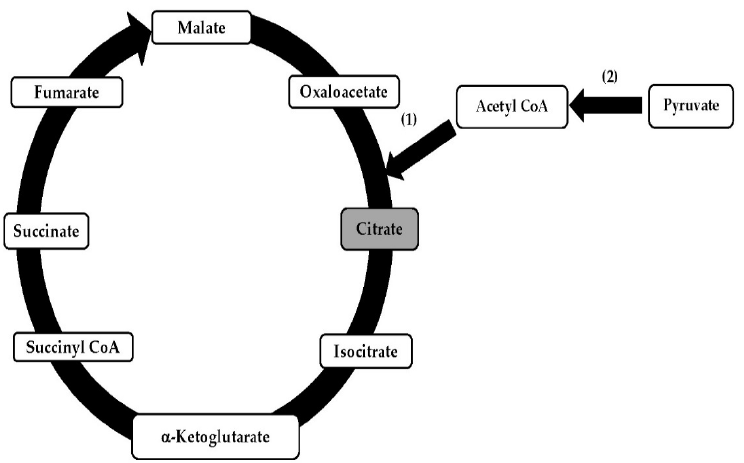
Figure 2. Citric acid synthesis by the citric acid cycle in Aspergillus niger . (1) Citrate synthase; (2) Pyruvate carboxylase. (2) Pyruvate